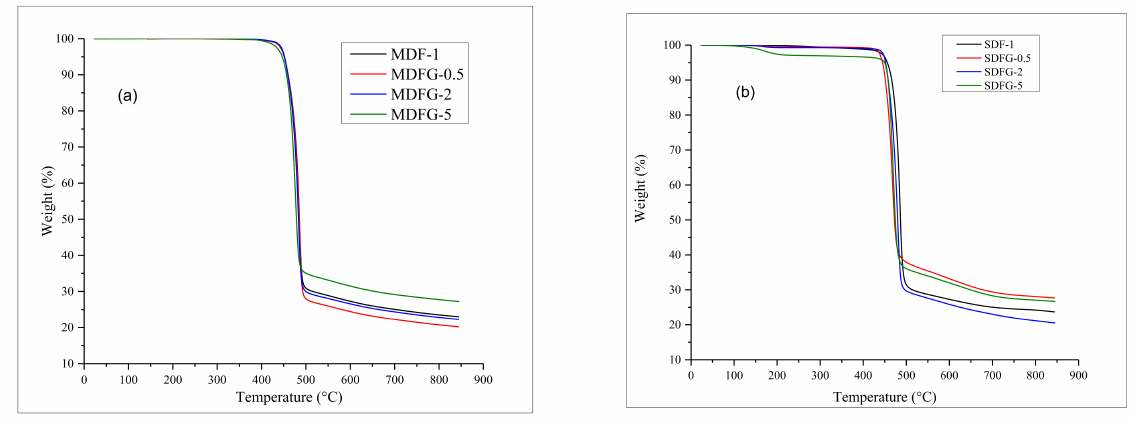
Figure 7. Overlay graphs of TGA of nanocomposites prepared by: ( a ) melt-mix method, and ( b ) solution-cast method.